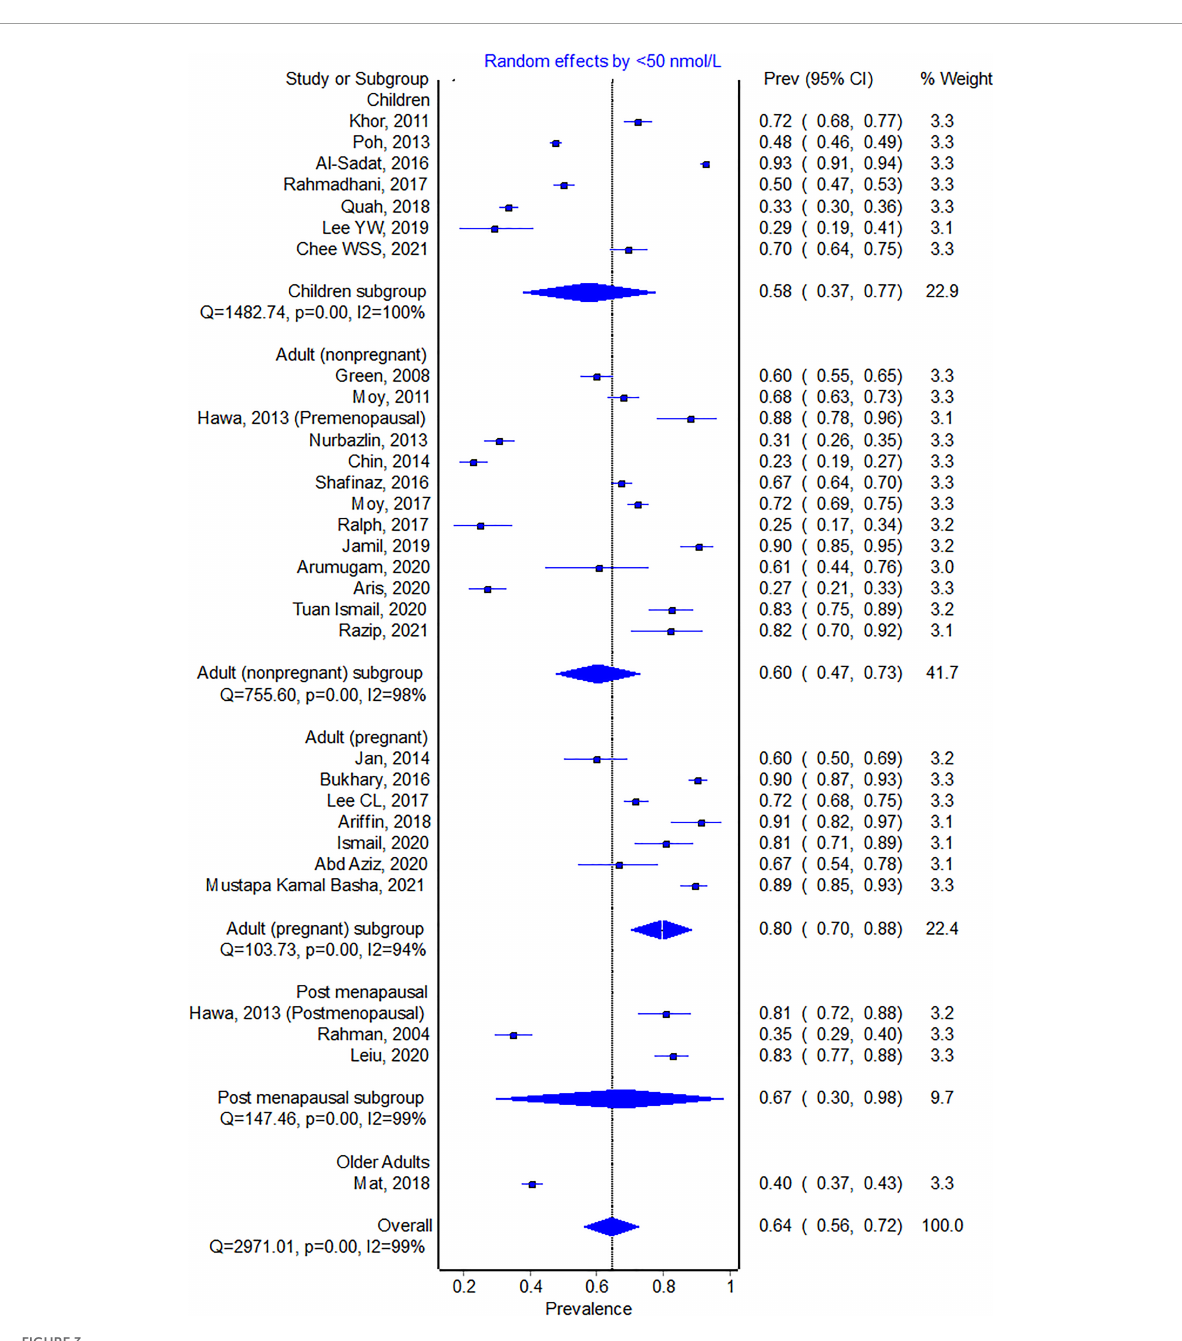
FIGURE3 Pooled proportion of the < 50 nmol/L 25-hydroxyvitamin D